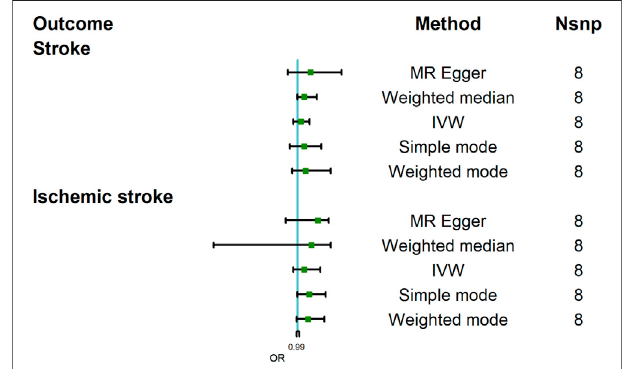
FIGURE 2 | Mendelian randomization analysis results about the causal effectsofCOVID-19susceptibilityonstrokeandischemicstroke.CI,credibility interval.